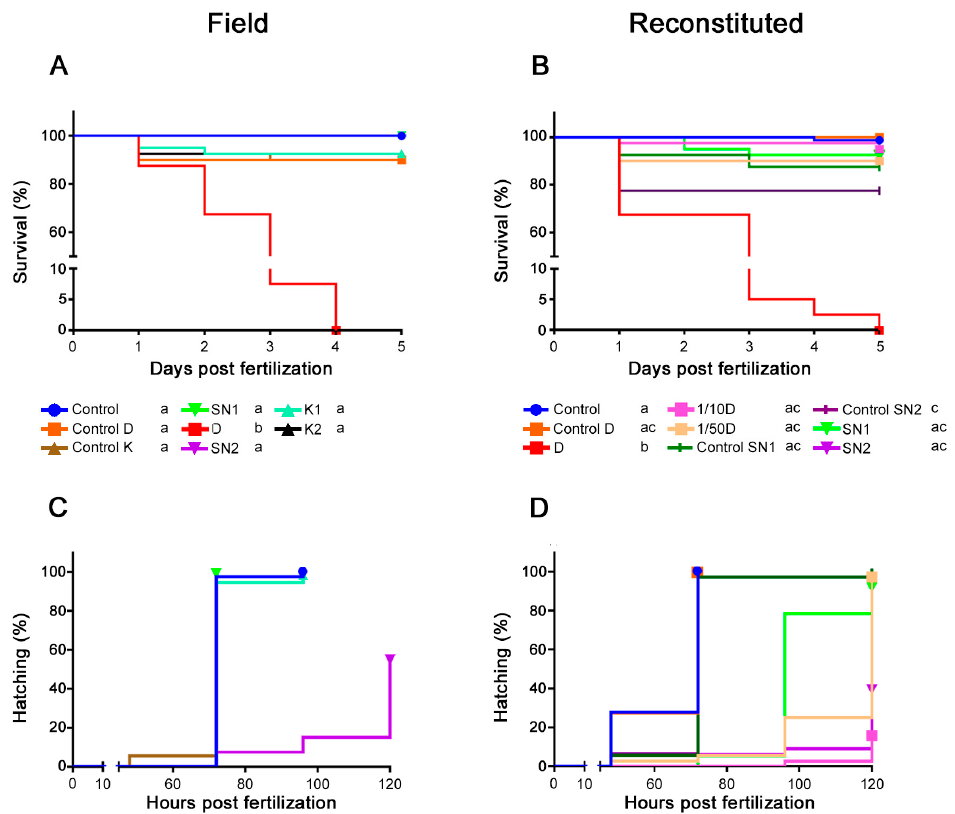
Figure 2. Survival curves after exposure to ( A ) field water samples, ( B ) reconstituted metal mixtures. Hatching curves after exposure to ( C ) field water samples and ( D ) reconstituted metal mixtures. Different small letters in the legend indicate significant differences within each graph. “Control” indicates rearing in standard embryo medium. In ( A , C ) separate controls (“control D” and “control K”), with pH and conductivity adjusted to those of the field water samples, were included. The pH